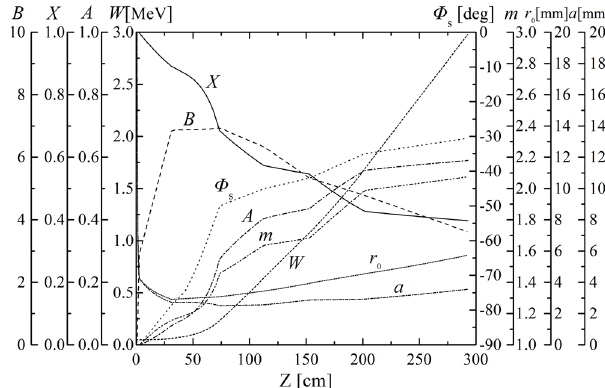
FIG. 2. Various parameters of the XiPAF RFQ versus longi- tudinal position: B is the focusing strength, X is the focusing parameter, A is the acceleration parameter, W is the synchronous energy, Φ is the synchronous phase, m is the modulation factor, s r a is the minimum bore 0 is the mean bore radius, and